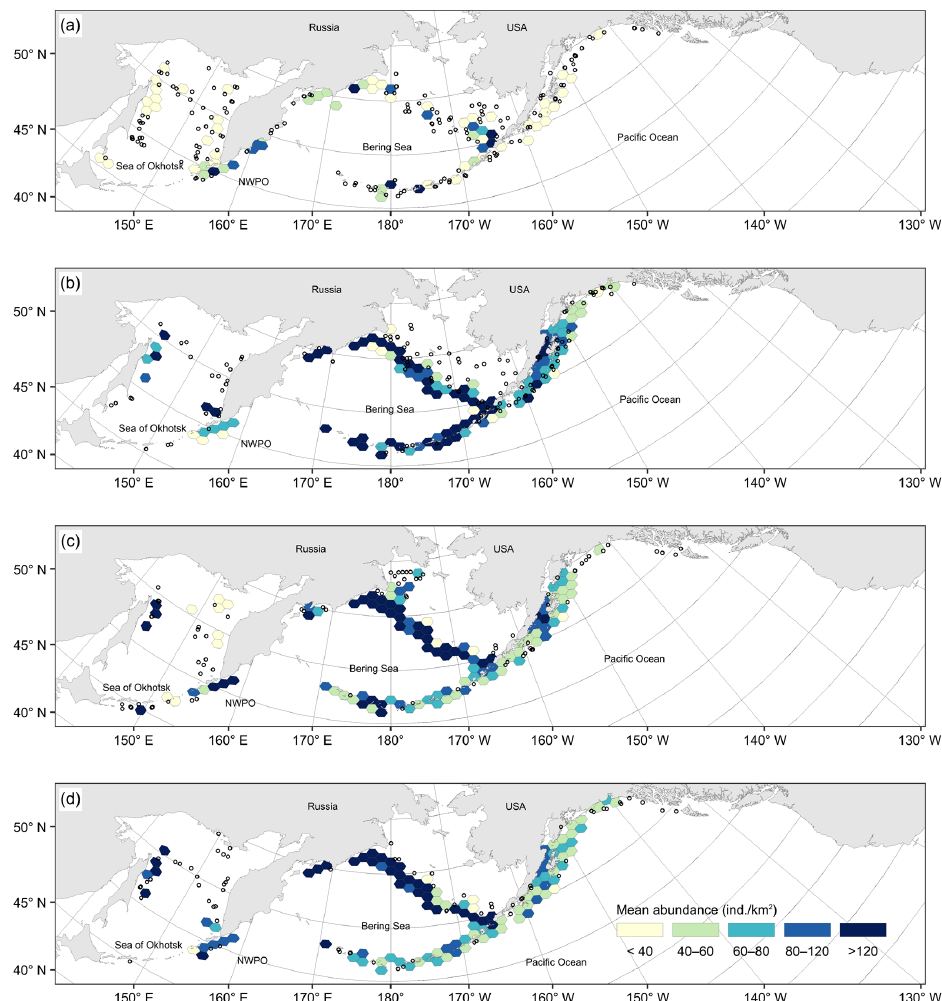
Figure 5. Mean abundance (ind./km 2 ) of the Aleutian skate Bathyraja aleutica in the North Pacific Ocean in 1976–1990 ( a ), 1991–2000 ( b ), 2001–2010 ( c ), and 2011–2019 ( d ). Small circles mark station locations outside of the hexagonal grid cells with at least three stations (see Methods).